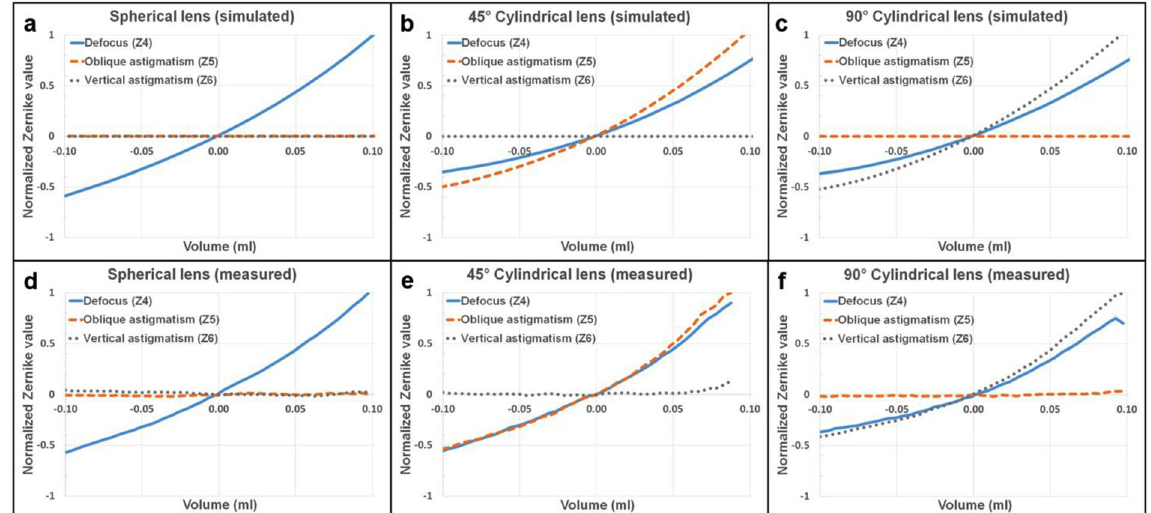
Figure 3. Simulated and measured data of normalized Zernike values. Variations of Zernike values related to defocus (Z4), 45° astigmatism (Z5), and 90° astigmatism (Z6) vs. the volume changes of liquid inside the simulated (a) defocus lens, (b) 45° astigmatic lens, and (c) 90° astigmatic lens. The corresponding measured results are represented for (d) defocus lens, (e) 45° astigmatic lens, and (f) 90° astigmatic